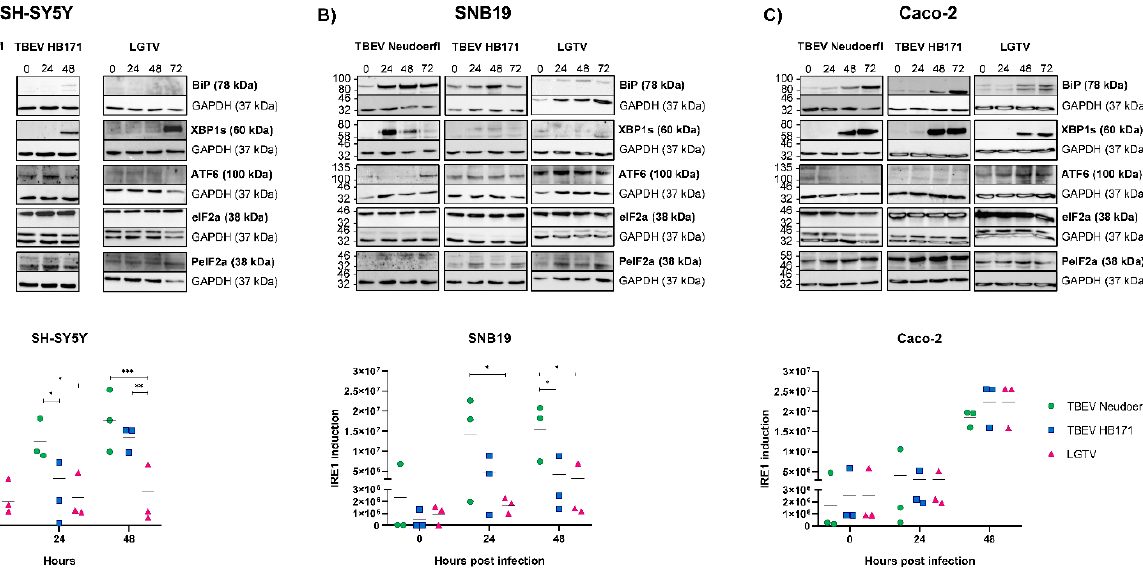
Figure 2. Induction of three different pathways of the unfolde protein response by the different tick-borne flaviviruses in neuronal ( A ), astrocyte ( B ) and intestinal ( C ) cells. Cells were infected at multiplicity of infection of 0.1 and cell lysates were collected at 0, 24, 48 and 72 h post infection. The lysates were analyzed by SDS-PAGE and Western blot probed for proteins of the IRE1 pathway (GRP78/BiP, XBP1), the ATF6 pathway (ATF6) or the PERK pathway (eIF2 α , p-eIF2 α ). The experiments were repeated three times and a representative blot is shown. GAPDH was included as a housekeeping control. Asterisks (*) indicate unspecific bands in GAPDH controls for eIF2 α due to incomplete stripping of the membrane and presence of residual eIF2 α signal. ( D ) Quantification of XBP1 Western blot signal intensities of three independent experiments and comparison of XBP1 protein levels in the three tested cell lines infected with each virus. Statistical analyses were performed by 2-way ANOVA with Tukey’s multiple comparison test, * p < 0.033, ** p < 0.002, *** p < 0.001 . kDa, kilodalton.